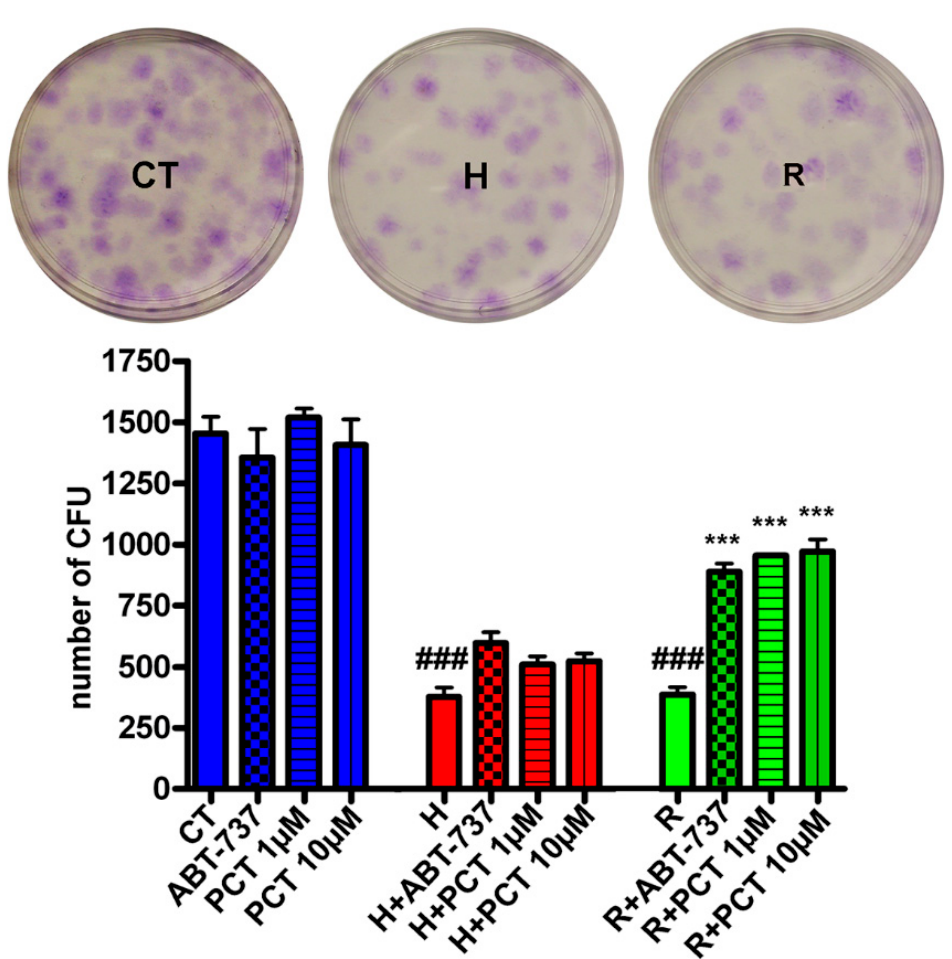
piceatannol further decreased the SIRT1 level (Figure 5 and Supplementary File S3). Of note, ABT-737 also reduced the SIRT1 expression.